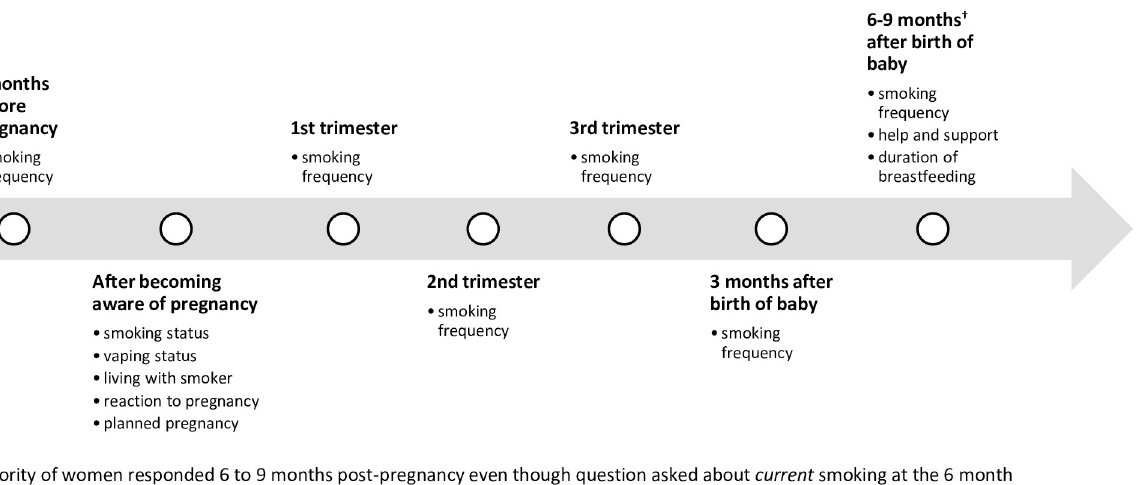
Fig 1. Timeline of when the factors explored in this analysis relate